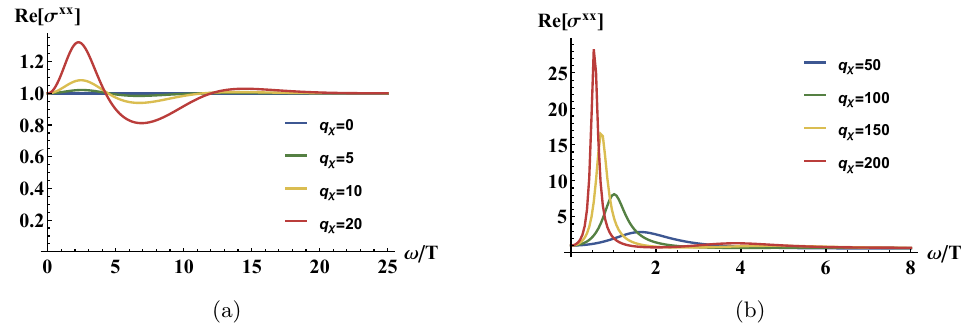
Figure 2 . q (cid:31) dependence of optical conductivity for (cid:22) = 0 and H = 0. Stronger interaction gives sharper peak at smaller frequency and sum rule is